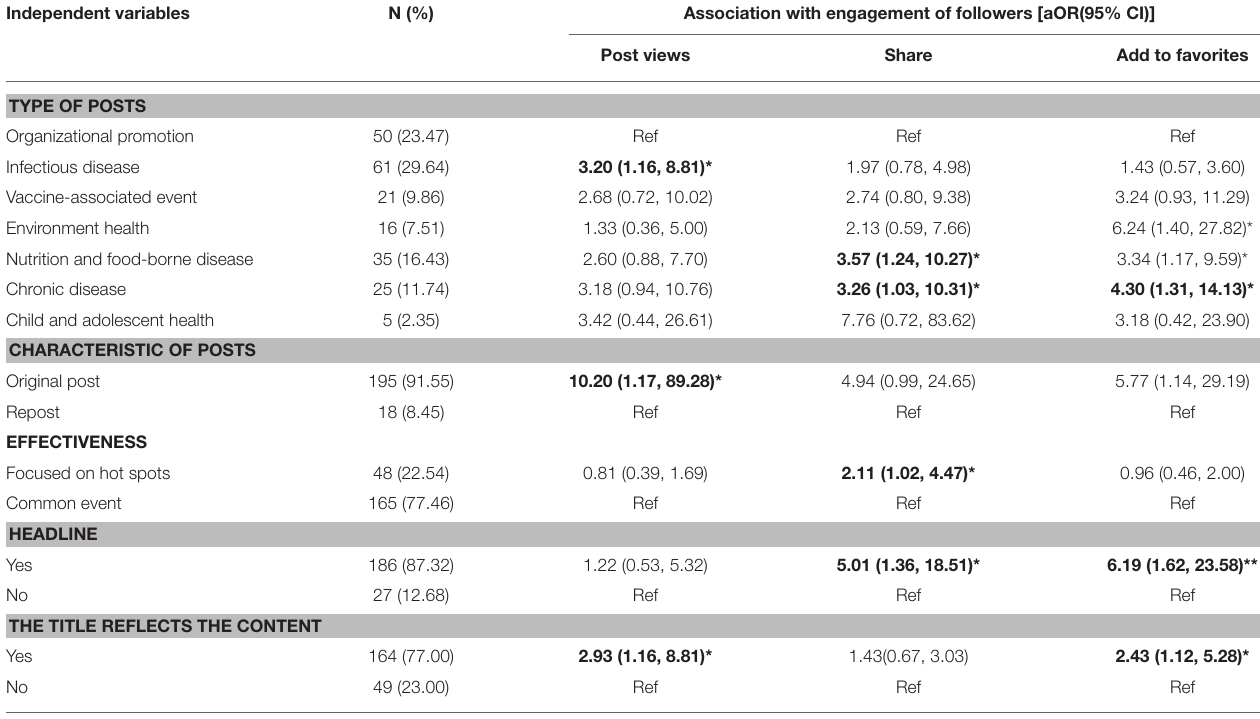
TABLE 2 | Factors associated with engagement of followers on posts by the Guangzhou CDC I-Health official WeChat account. Independent